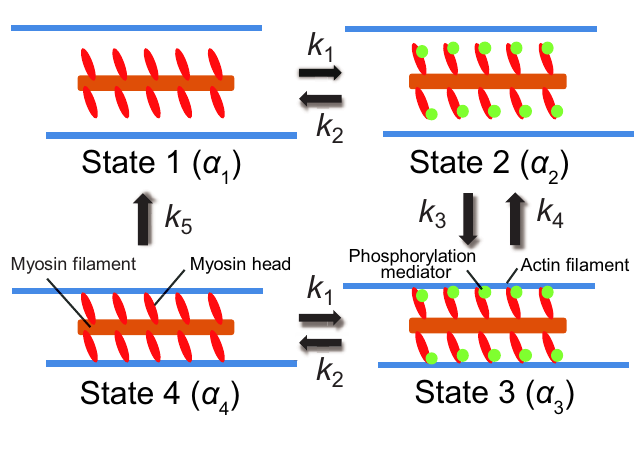
Fig. 2 Schematic of chemical model proposed by Hai and Murphy (1988): α 1 , α 2 , α 3 , and α 4 represent the chemical state fractions of the myosin head and k 1 , ··· , k 5 are reaction rates. The phosphorylation of the myosin head is controlled by calcium